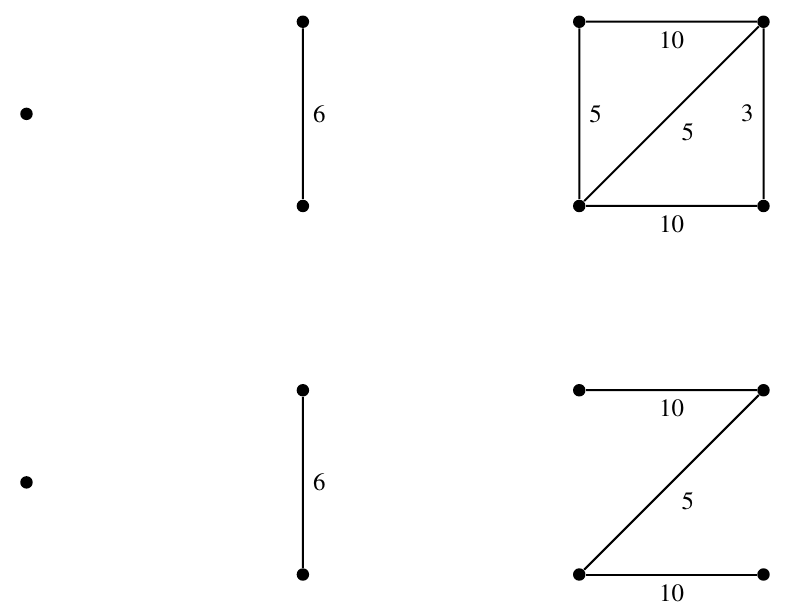
Figure 1: A graph G and a heaviest subforest. Edge weights are